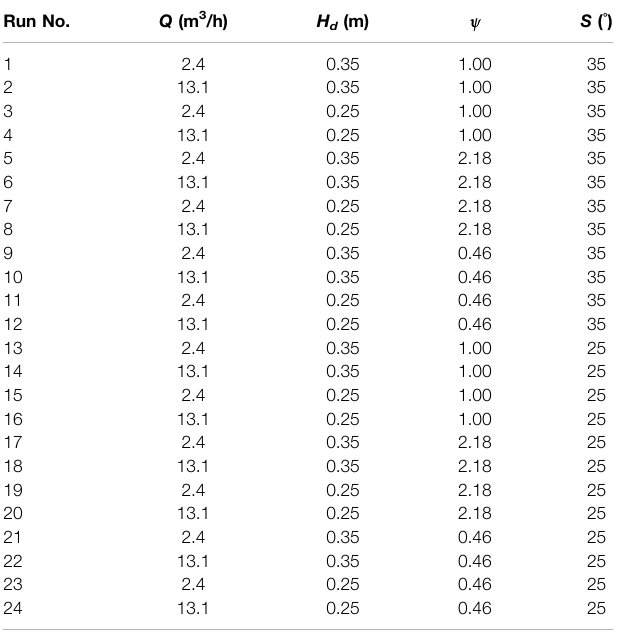
TABLE 1 | Summary of experimental conditions in this study. Run